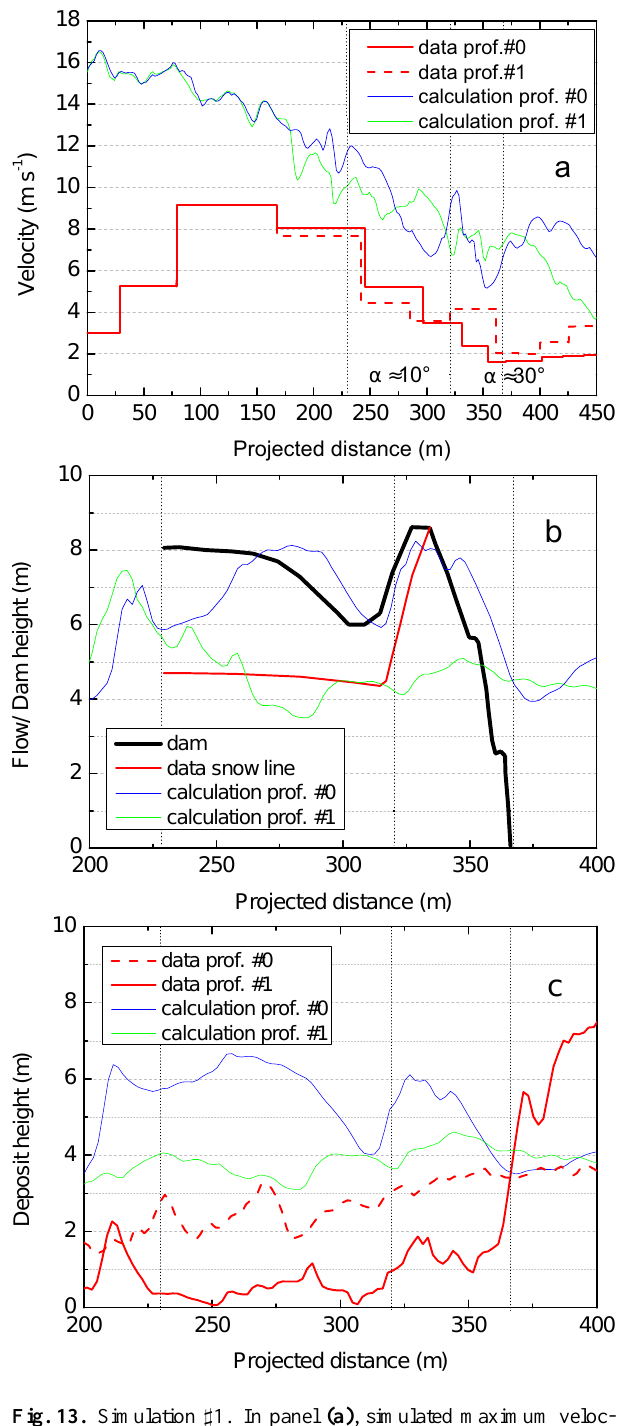
Fig. 13. Simulation ] 1. In panel (a) , simulated maximum veloc- ities are compared to measured front velocities, in panel (b) , sim- ulated maximum flow depths to the snow line at the dam location and in panel (c) , simulated deposit heights to laser scanning mea- surements. Velocity, flow and deposition depths refer to the profiles drawn in Fig. 10, upper panel. Vertical dotted lines indicate the dam location.